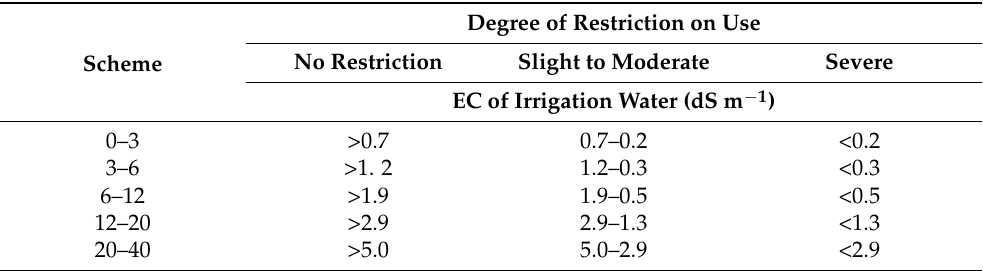
Table 7. Guidelines for the interpretation of irrigation water quality according to the joint sodium adsorption ratio and electrical conductivity content